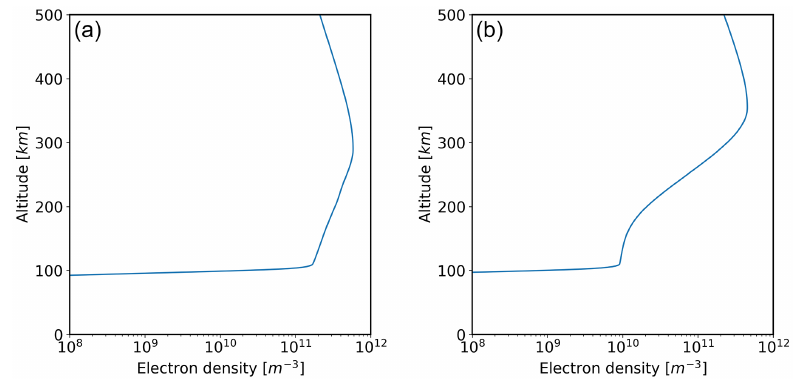
Figure 2. Electron density profiles for test 1 ( a , midday) and test 2 ( b , midnight).